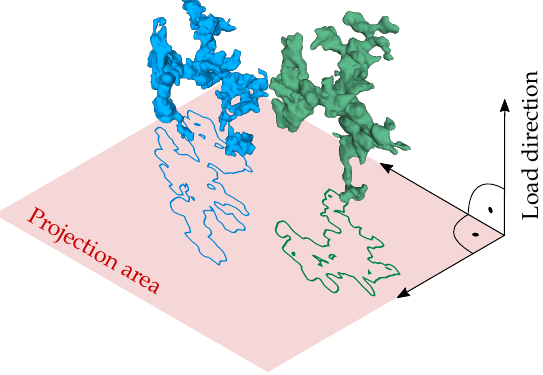
Figure 16. Evaluated crack propagation based on in-situ XCT after 2E5 load cycles